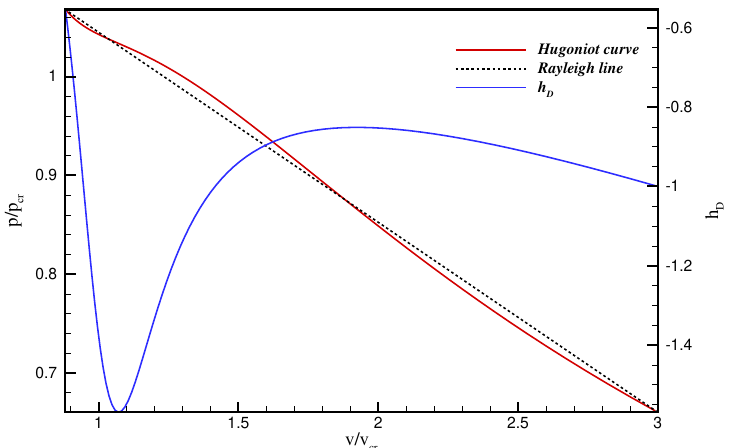
Figure 11. Case(3): The plot of h D and the Hugoniot curve as a function of the downstream specific volume. It is visible that the Hugoniot curve has more than two intersection points with the Rayleigh line. In addition, as the volume decreases, there are regions where h D < − 1.